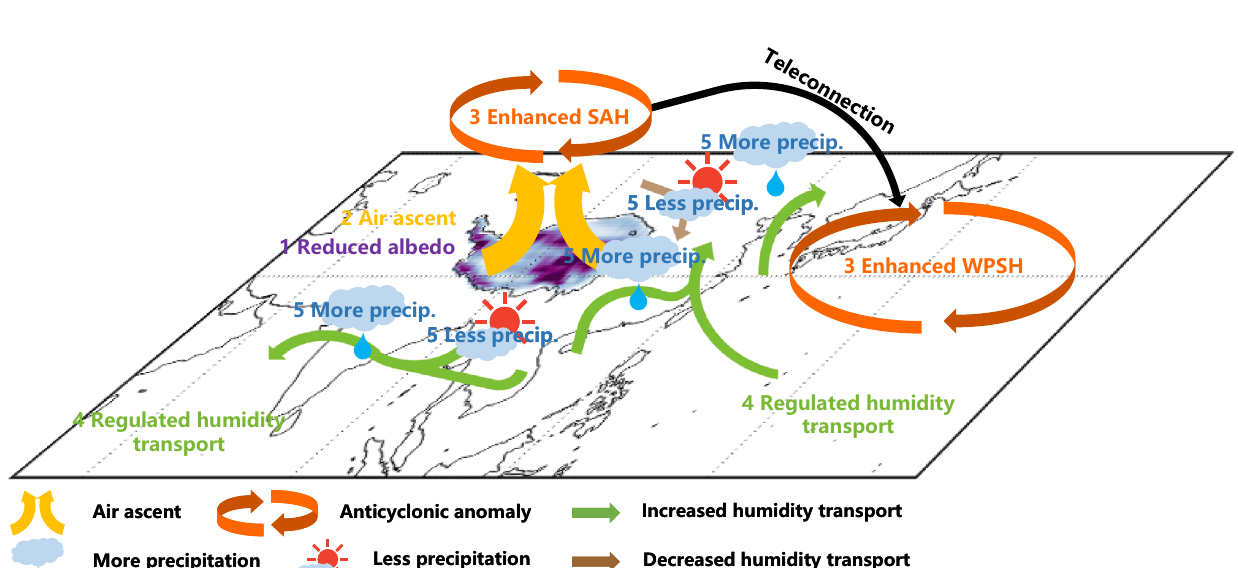
Fig. 3 | Schematic diagram of the impact of the Tibetan Plateau (TP) surface darkeningontheAsianSummerMonsoon. Thebasemapofthe fi gureisderived from Supplementary Fig. 1. The black line indicates the boundary of TP. Reduced albedoin the TP(stepone)modulates the local energy budget and thus intensi fi es the role of TP as an “ elevated heat pump ” , which ascends more air parcels (step two) and further favors the formation of the atmospheric anticyclonic anomaly (SouthAsianHigh,SAH)andthedownstreamWestPaci fi cSubtropicalHigh(WPSH) through the Rossby wave trains (step three) 33 – 35 . On the one hand, the intensi fi ed anticyclonic anomaly in the troposphere causes the strong easterly wind anomaly over South Asia, which weakens the climatological westerly humidity transport